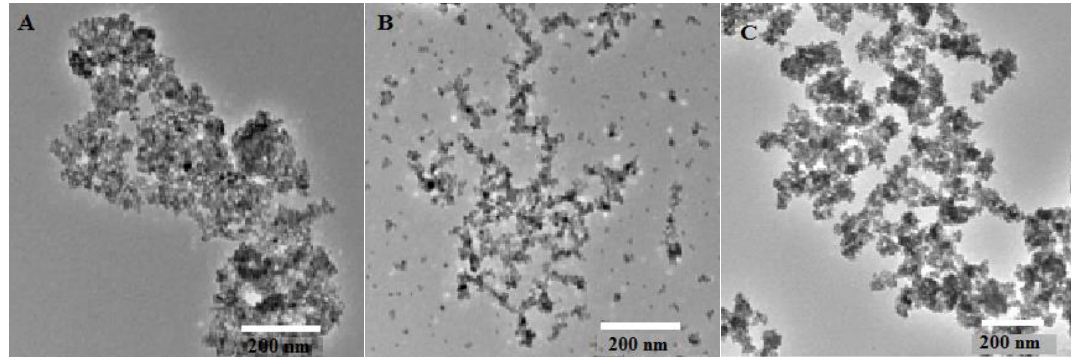
Figure 3. TEM images of ( A ) TiO 2 , ( B ) TC, and ( C ) PPTC.